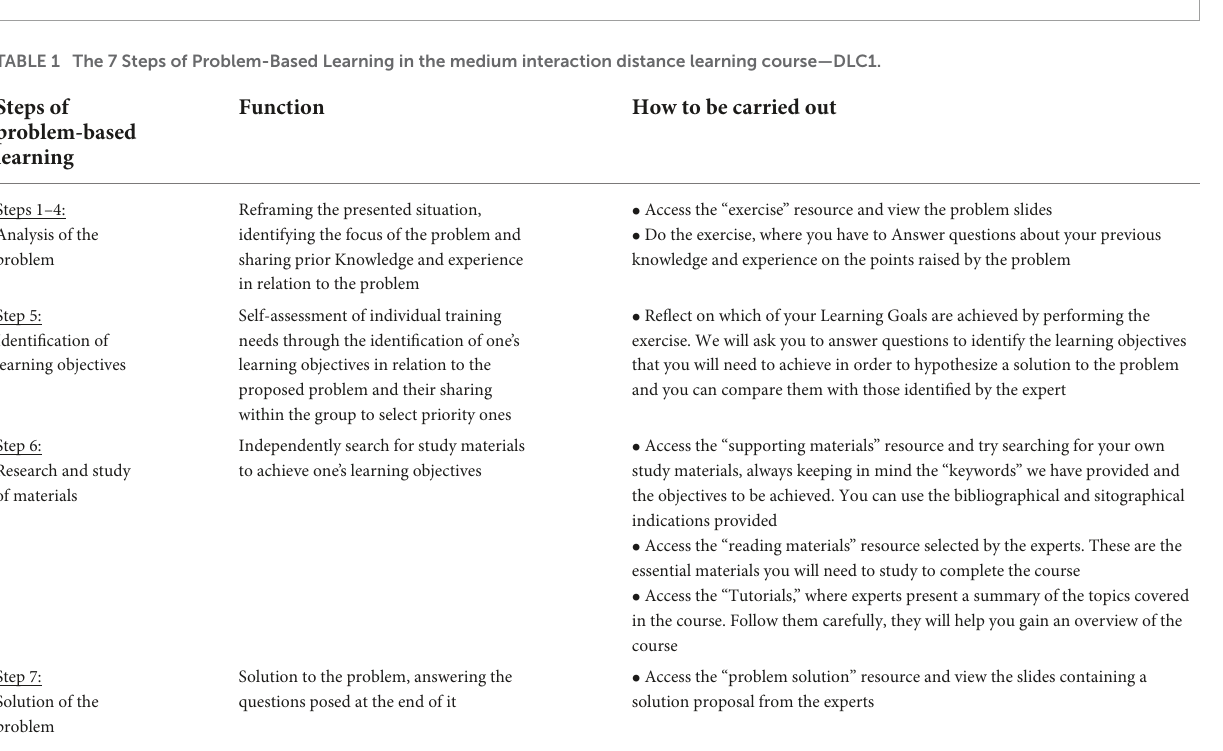
FIGURE2 IV SCAI ADULT course path